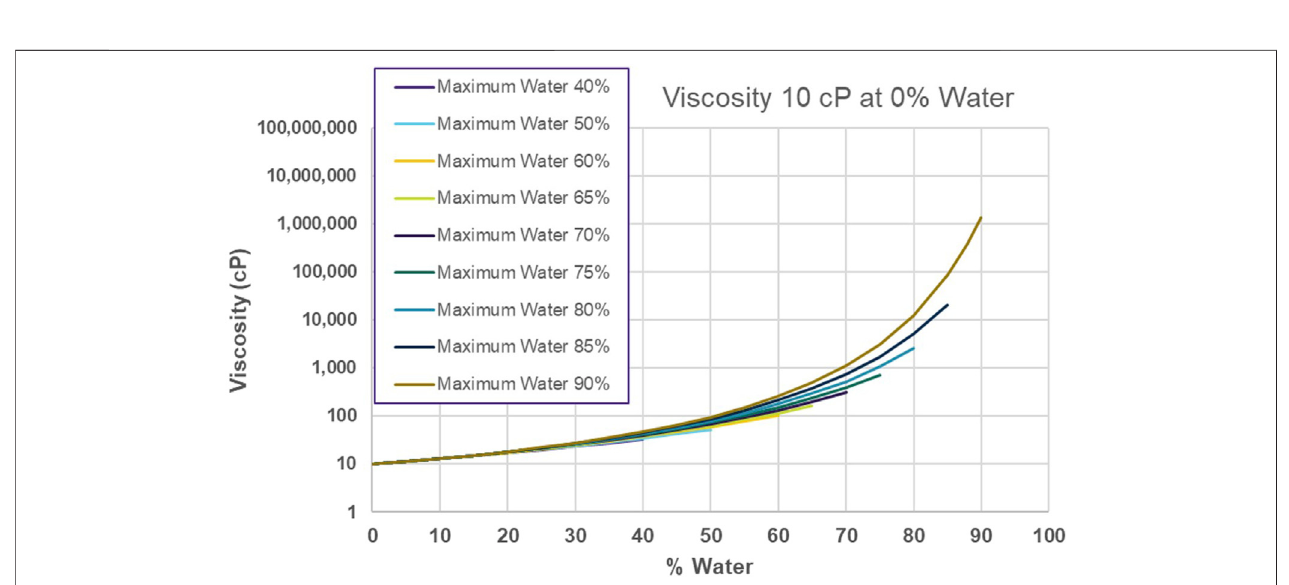
FIGURE 2 | Viscosity changes with water content for oils with an initial viscosity of 10 cP and varying maximum water content.